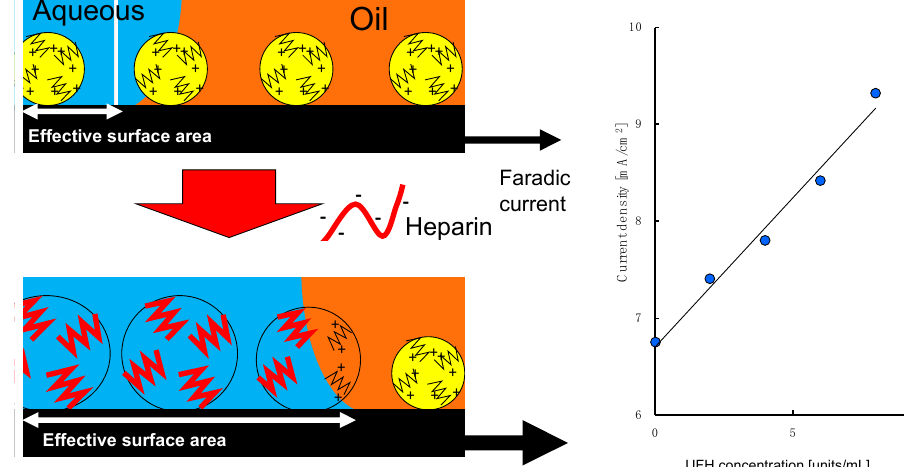
Figure 7. Scheme of the possible mechanism of heparin sensing with a paste electrode produced by mixing oil and graphite particles grafted with UFH-MIP, where the faradic current increased with the UFH concentration as shown on the right-hand side [16].